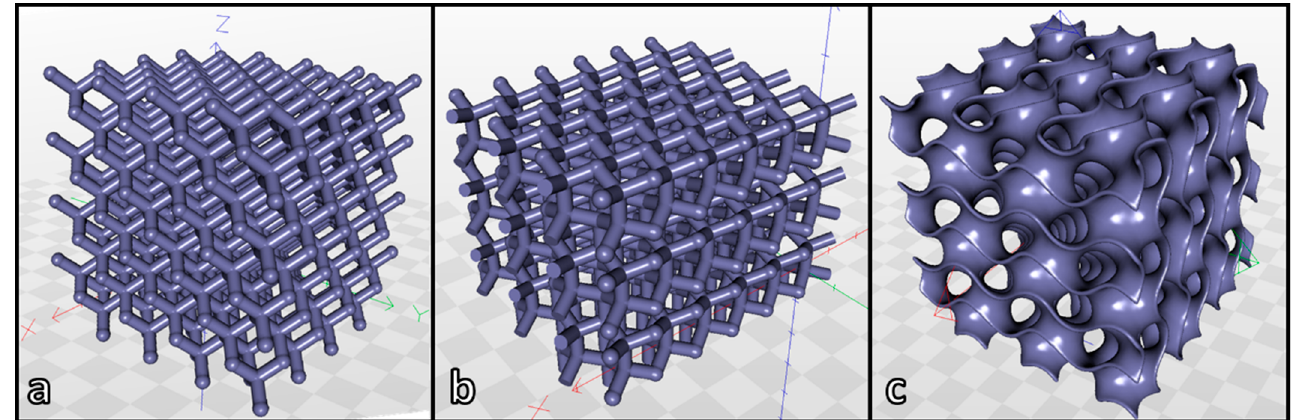
Figure 7. Reference three ‐ dimensional models adopted for MSLA scaffolds: ( a ) diamond symmetry; ( b ) wurtzite symmetry; ( c ) gyroid.